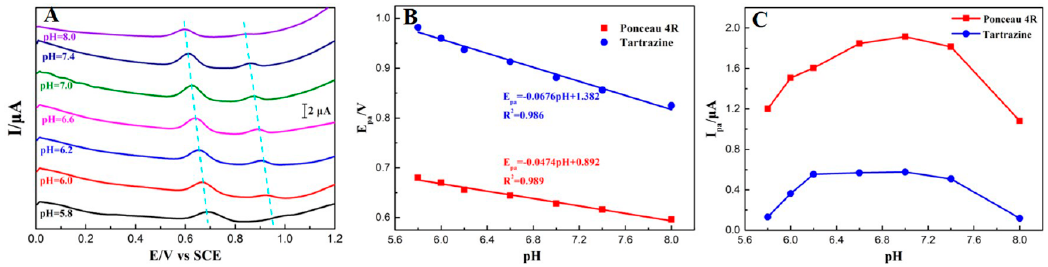
Figure 4. Effect of deposition potential ( A ) and deposition time ( B ) on the DPV anodic peak currents of ponceau 4R and tartrazine. (A) Deposition time was set at 150 s and (B) deposition potential was fixed at − 0.1 V.